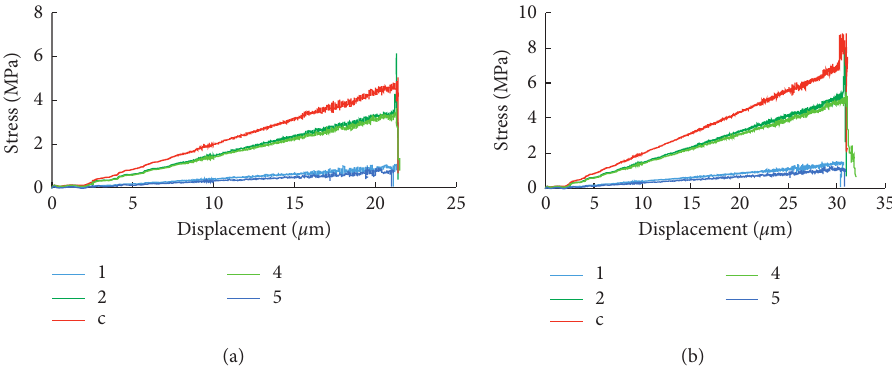
Figure 27: Stress-displacement changes of splitting points of 45 ° bedding shale with different contact cohesion. (a) 0.8. (b) 1.2.